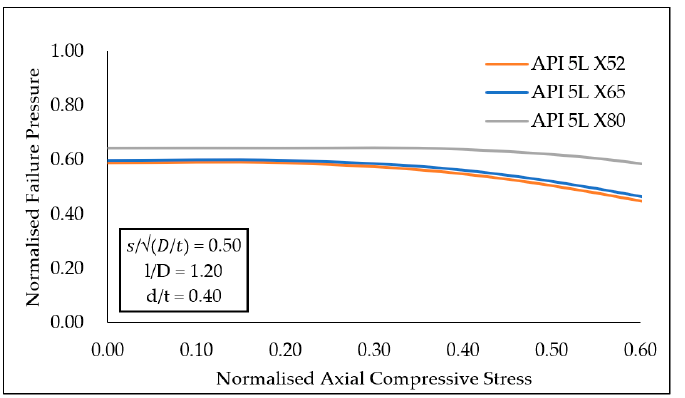
Figure 10. Failure pressure predictions for API 5L X52, X65, and X80 pipes for multiple normalised effective defect depths.